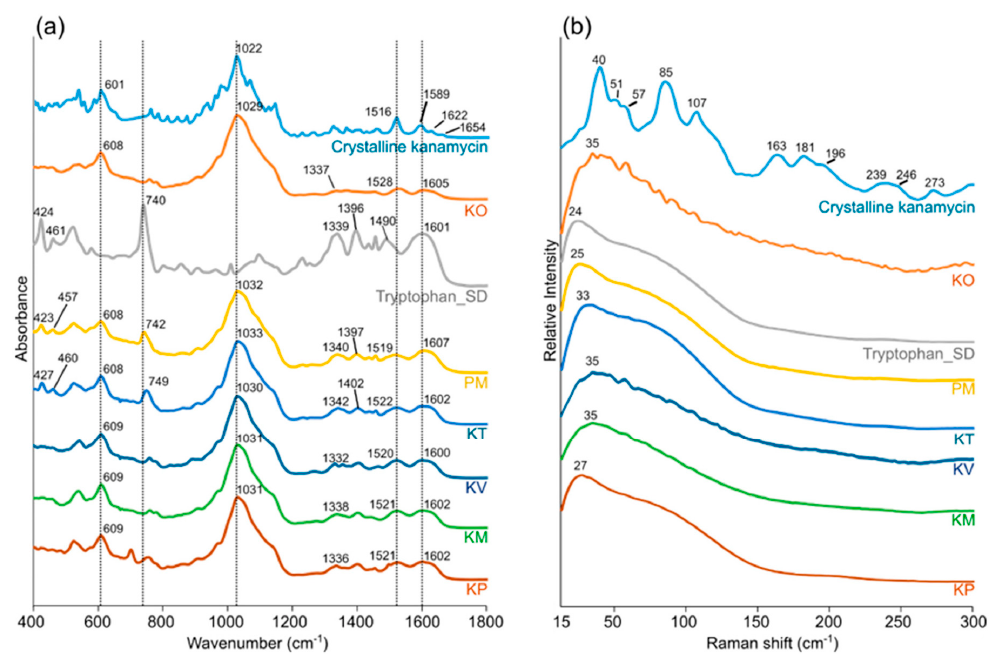
Figure3. Representative( a )FourierTransformInfrared(FTIR)and( b )Low-FrequencyRaman(LFR)spectra of the di ff erent particles. From top to bottom: Crystalline kanamycin, kanamycin only formulation (KO), spray-dried tryptophan (Tryptophan_SD), a physical mixture (1:1) of amorphous kanamycin and amorphous tryptophan (PM), kanamycin-tryptophan formulation (KT), kanamycin-valine formulation (KV), kanamycin-methionine formulation (KM), and kanamycin-phenylalanine formulation (KP). Pharmaceutics 2020 , 12 , x FOR PEER REVIEW